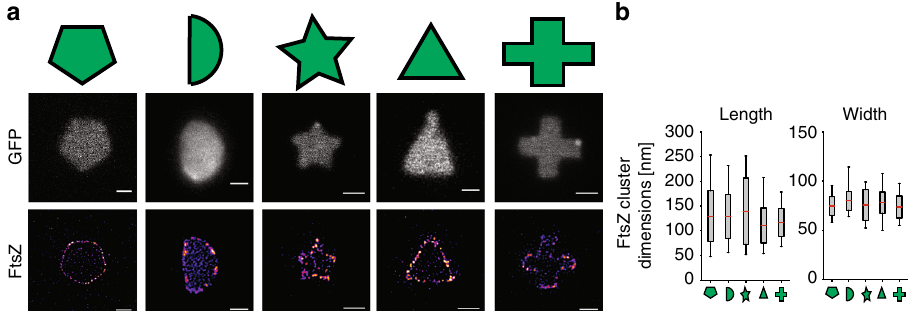
Fig. 6 FtsZ bundle dimensions in complex shapes. a Cells expressing cytosolic GFP or FtsZ-mCitrine were remodeled into various shapes. Top row, schematic representation of the cell shapes (colored green for visualization). Middle row, representative cells expressing cytosolic GFP, and sculpted in the corresponding shapes. Bottom row, an FtsZ-pentagon, FtsZ-half-moon, FtsZ-star, FtsZ-triangle and FtsZ-cross in sculpted cells. Scale bars = 1 μ m. b Quanti fi cation of FtsZ cluster lengths and widths in shaped cells. Cluster dimensions in pentagons ( l = 131.4 ± 52 nm, w = 74.6 ± 9.5 nm, n = 121), half- moons ( l = 129 ± 45 nm, w = 79.9 ± 9.6 nm, n = 98), stars ( l = 139.6 ± 67 nm, w = 75.5 ± 15.5 nm, n = 113), triangles ( l = 110 ± 35 nm, w = 78 ± 10.7 nm, n = 81) and crosses ( l = 118.9 ± 21 nm, w = 71.1 ± 17.8 nm, n = 45). l, length, w, width. Boxes represent S.D., with red lines indicating mean. Whiskers on the box plots encompass 95.5% of the